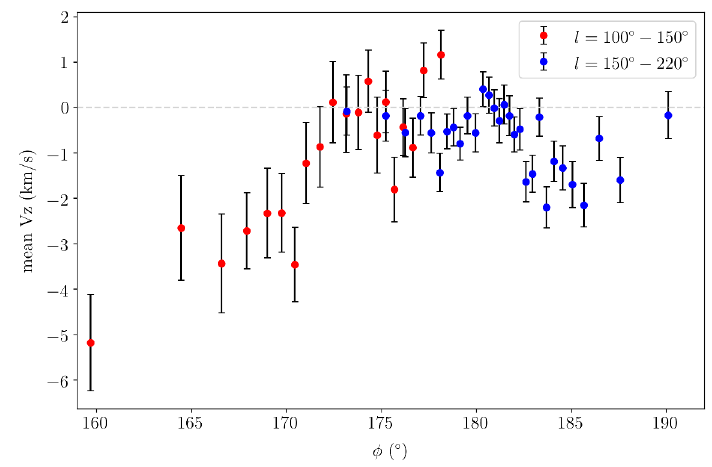
Figure 3. Mean V Z as a function of φ for warp down and warp up region. Warp down and warp up region are presented by red dots and blue dots, respectively. Each data point is consisted of 150 stars, with no